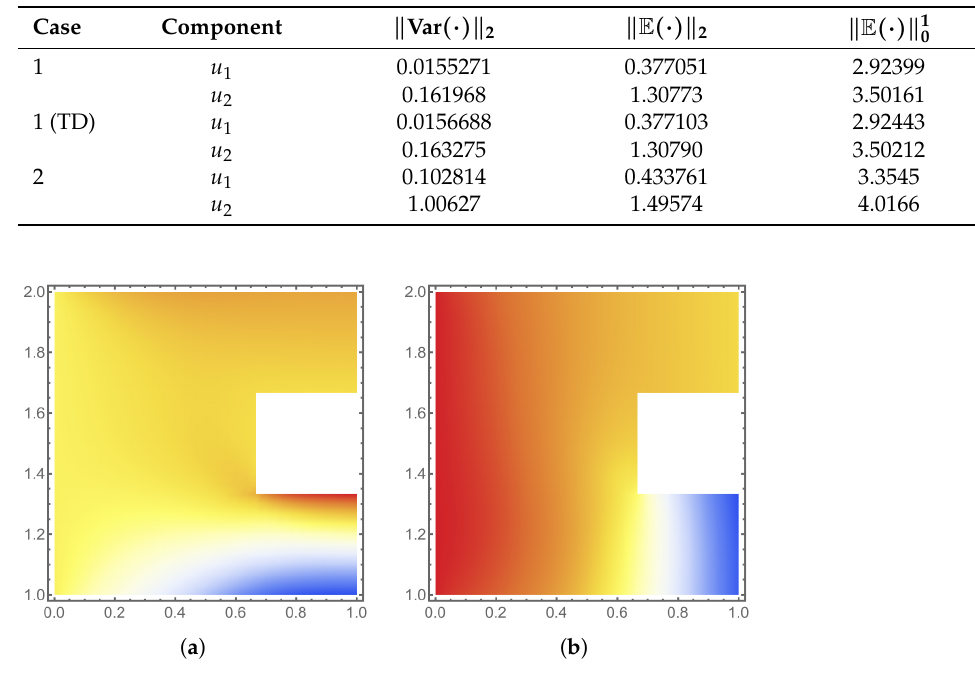
Figure 3. Three layers of uncertain materials. Examples of expected solutions. Temperature scale with zero level at the boundary x = 0. ( a ) E ( u 1 ) ∈ [ − 1.80,0.83 ] , ( b ) E ( u 2 ) ∈ [ − 4.85,0 ] . Decay rates: